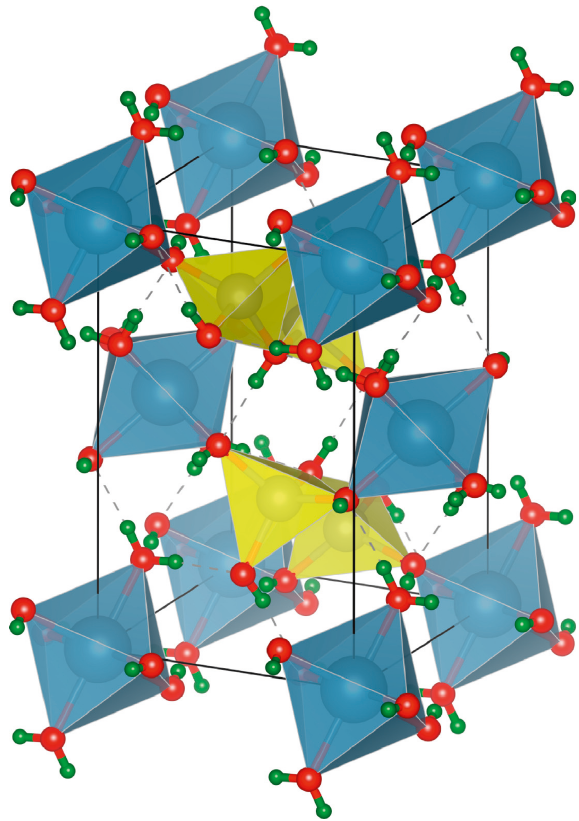
Figure 1: Schematic of the crystalline structure of qatranaite showing the tetrahedrally coordinated zinc (ZnO 4 ; yellow) and octahedrally coordinated calcium (CaO 6 ; blue) clusters. The red and green spheres denote oxygen and hydrogen atoms,